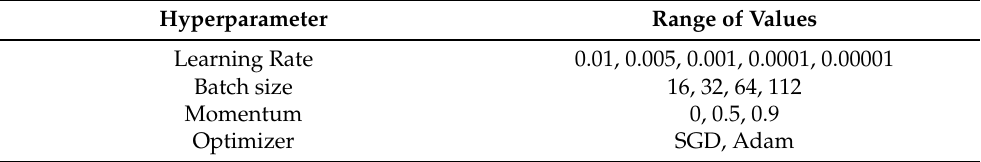
Figure 2. The high intensity masking technique developed to extract BME features on fluid-sensitive sequences. First, the mean ( µ ) and standard deviation ( σ ) of the bone signal intensities are calculated; then, using these values, the image intensities are clamped, and a histogram equalization using the MinMax algorithm with values 0 and 255 applied. The resultant image is obtained by only considering the regions within the bone. Table 2. List of values used for hyperparameter optimization in the training from scratch.